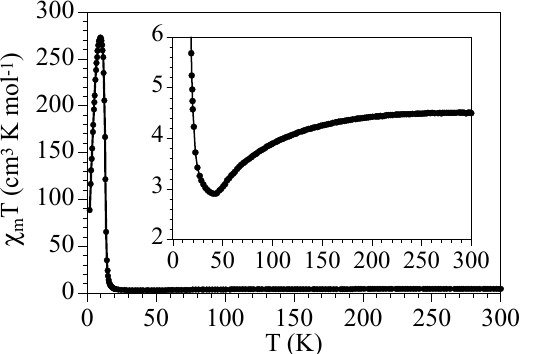
Figure 6. Thermal variation of χ m T for compound 1 . Inset shows the high-temperature region.